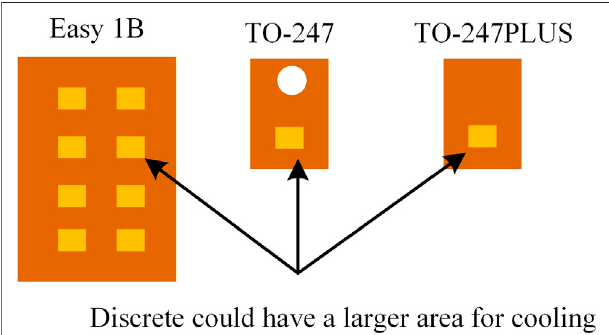
FIGURE 1 | Comparison of available cooling area in module vs discrete